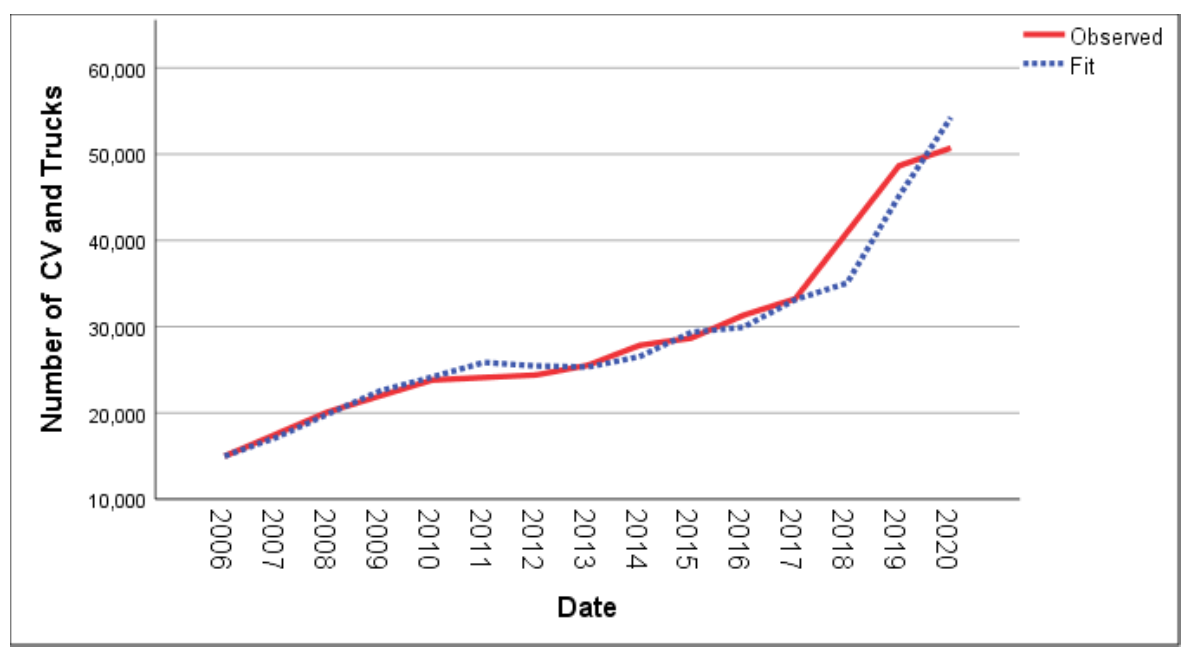
Figure 2. Observed and fit values of the developed prediction model .